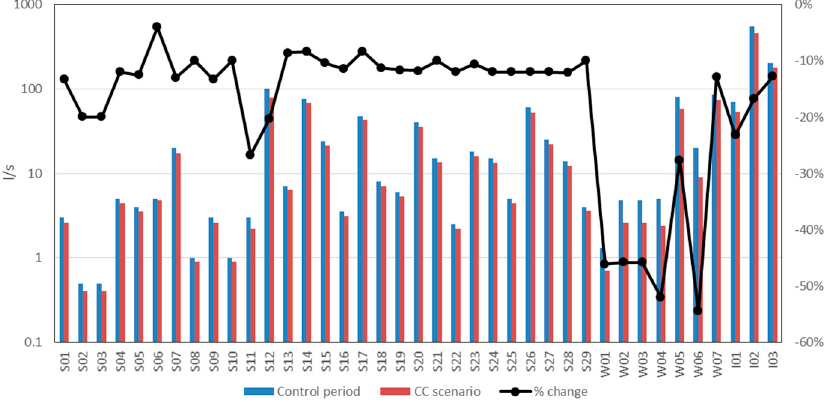
Figure 5. Projected absolute (histogram) and percent (line) changes (2016–2050 vs. 1971–2005) in the available flow of each of the 39 source nodes.